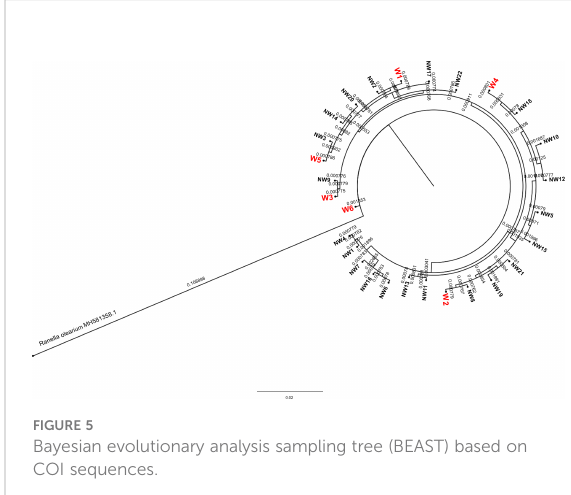
FIGURE 5 Bayesian evolutionary analysis sampling tree (BEAST) based on COI sequences.